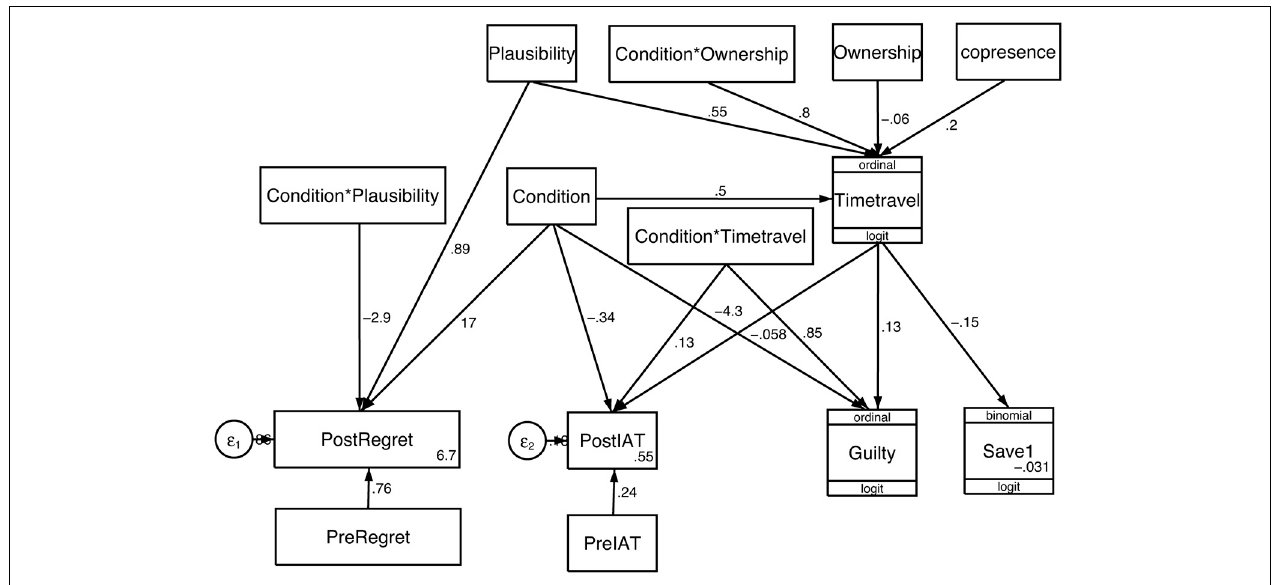
FIGURE 3 | Path analysis corresponding to Table 5. The directional edges represent hypothesized directions of causality. The numbers on the edges are the coefficients of the linear predictor of the